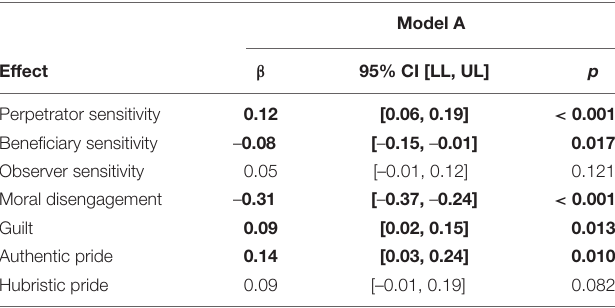
TABLE 7 | Regression model of pro-environmental intention after backward elimination of Model A.